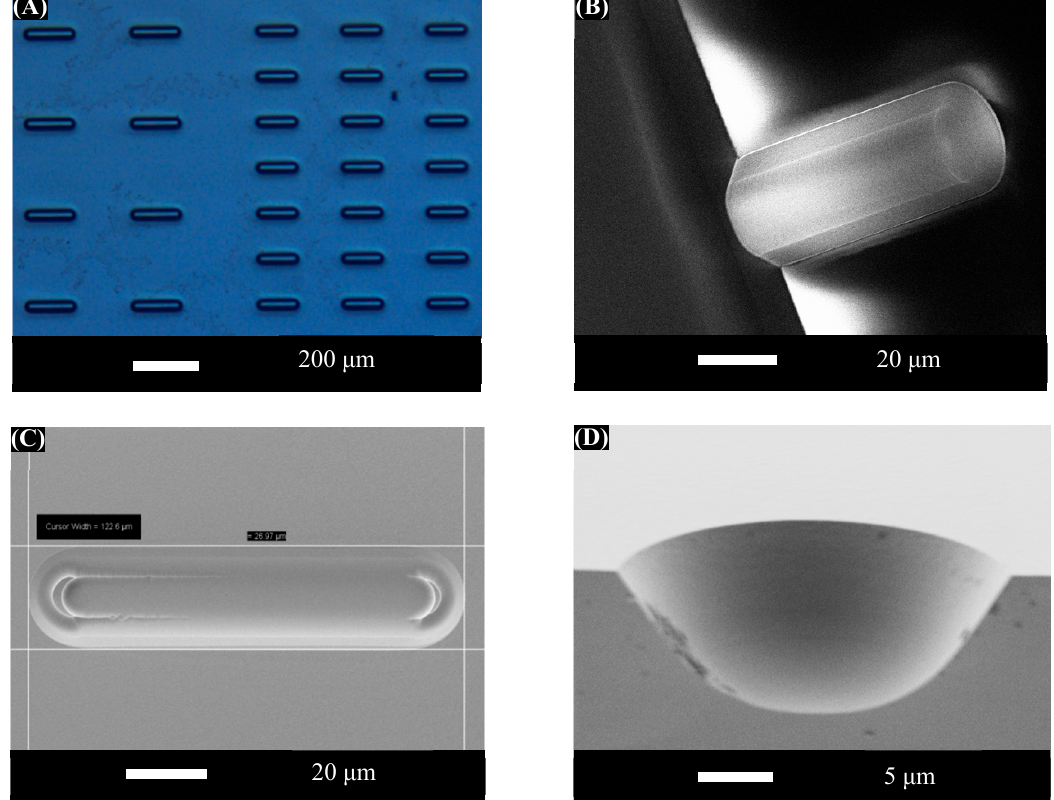
Figure 3. ( A ) Optical micrograph of a portion of the template showing assembly sites with diameter of 26 μ m and two different lengths and spacings. ( B ) Angled scanning electron microscope (SEM) cross-sectional cutaway image of one of the assembly sites. ( C ) Top view SEM image of an assembly site. ( D ) Cross-sectional cutaway SEM image of an assembly site showing the smooth sidewalls created using isotropic BOE etching.